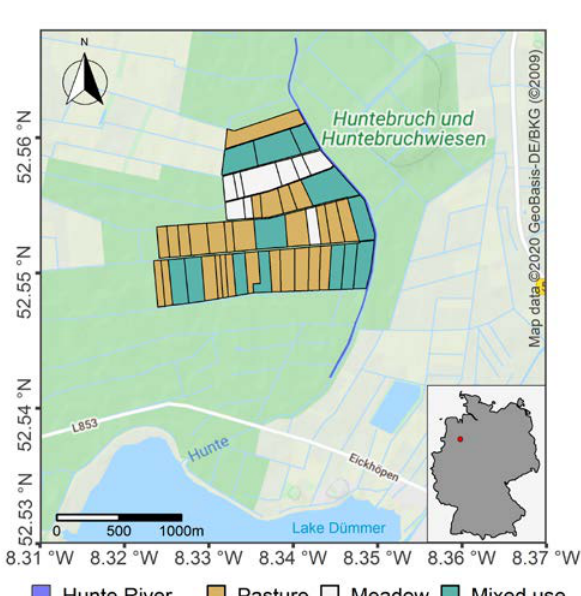
Figure 1. Map of the Osterfeiner Moor study area in northwest Germany (red point), highlighting different grassland management practices and the Hunte river (Google Maps; Kahle & Wickham